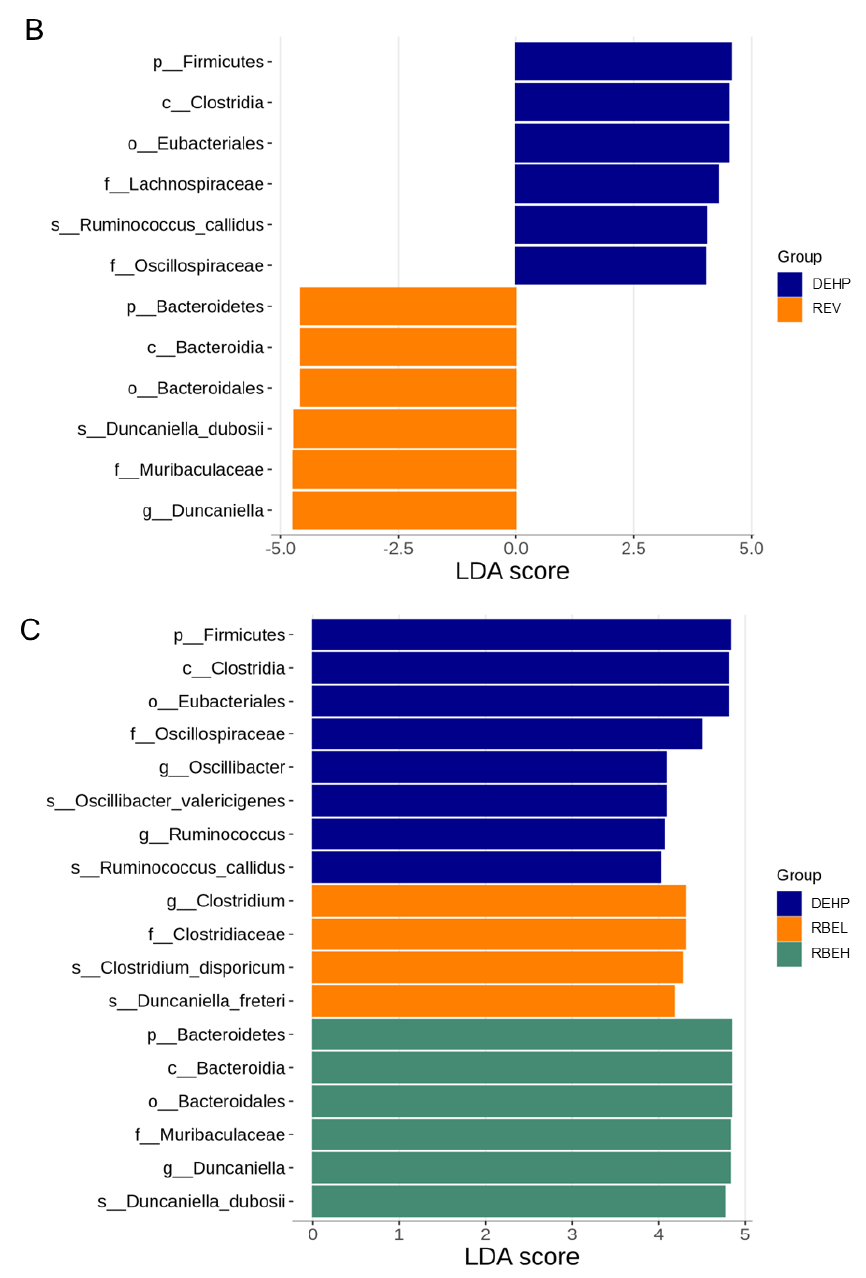
Figure 8. Linear discriminant analysis effect size (LEfSe) comparing the differentially abundant taxa between ( A ) all five groups; ( B ) the DEHP and REV group; and ( C ) the DEHP, RBEL, and RBEH groups. The linear discriminant analysis (LDA) score threshold was set to greater than 4.